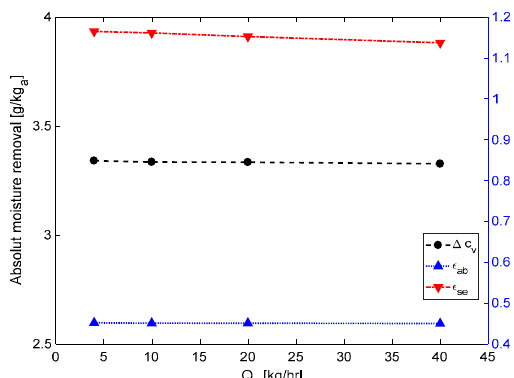
Figure 8. Effects of the solution flow rate on the absolute moisture removal, absorption, and sensible effectiveness parameters.